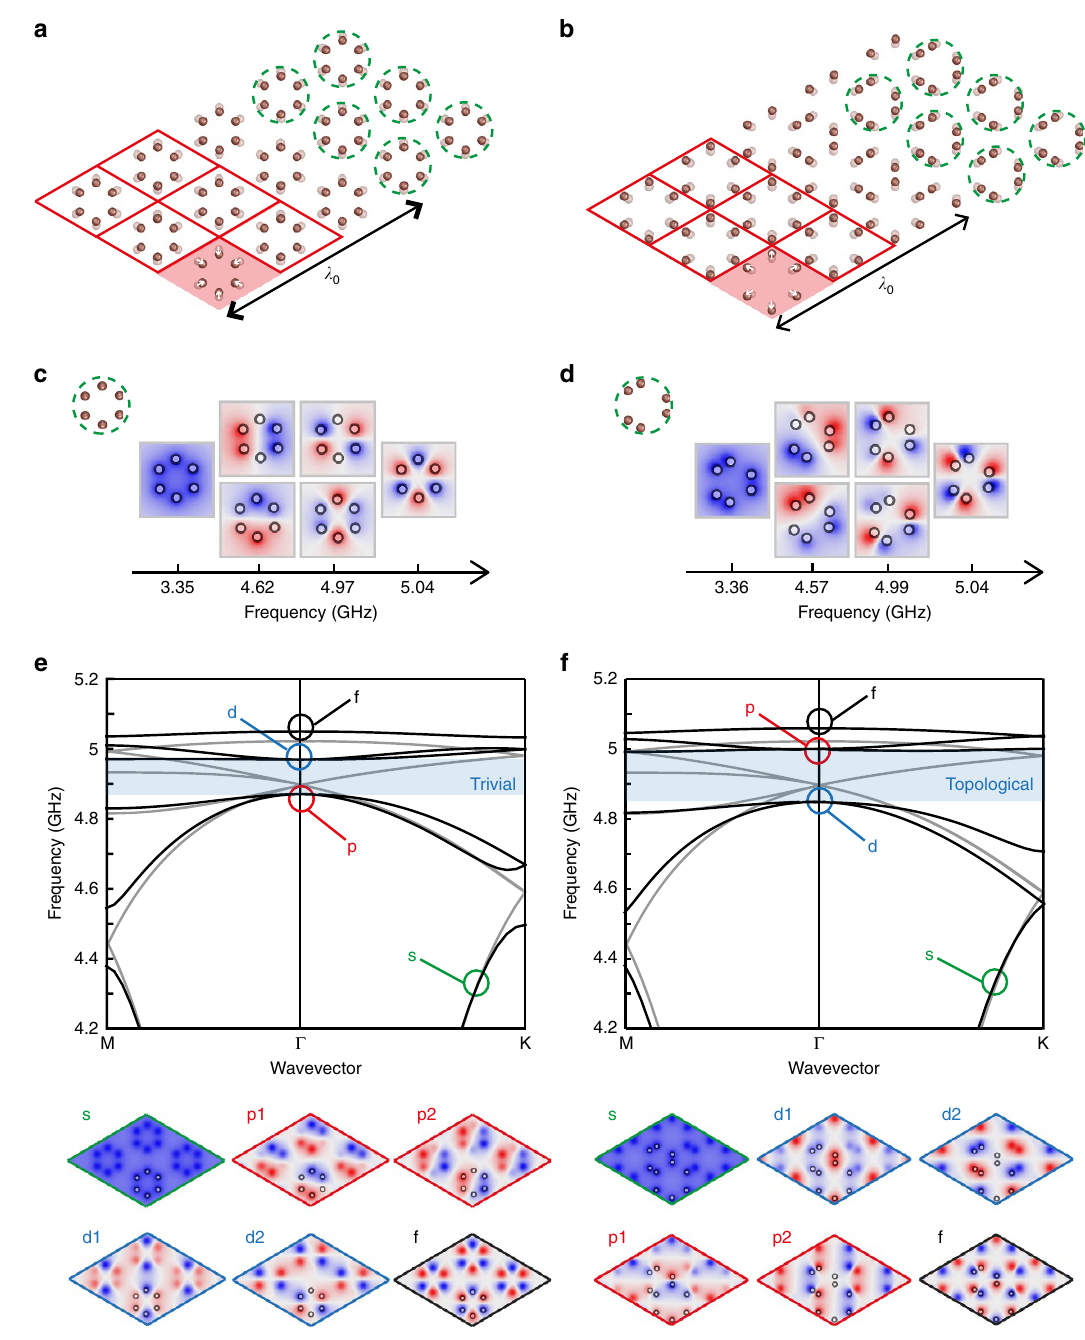
Figure 2 | Opening of a topological band gap by subwavelength structural modifications. ( a ) Starting from the honeycomb lattice in the extended unit cell picture of Fig. 1e, we shrink the size of the hexagonal arrangement of resonators composing each unit cell, obtaining a triangular lattice of hexagonal metamolecules (circled in green). Conversely, in b we expand the size of the hexagons, obtaining an array composed of a different metamolecule involving a trimer of resonator pairs (circled in green). ( c , d ) The resonant modes of the two metamolecules, responsible for the six bands observed in the band structures of the two crystals ( e , f ). ( e ) The band structure of the lattice of shrunk hexagons, and the associated electric field distribution for the Bloch modes of the six bands at the G point. ( f ) Similar to e for the lattice of extended hexagons, except that the p and d bands are now inverted with respect to the bandgap. As demonstrated in the text, the bandgap (blue shaded area) in e is topologically trivial, whereas the one in f is associated with a non-trivial